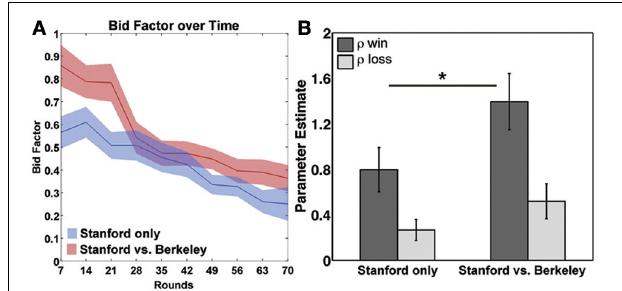
FIGURE 2 | (A) Development of the bidfactor over time and (B) parameter estimates of the utility of winning and losing. ∗ p < 0 .